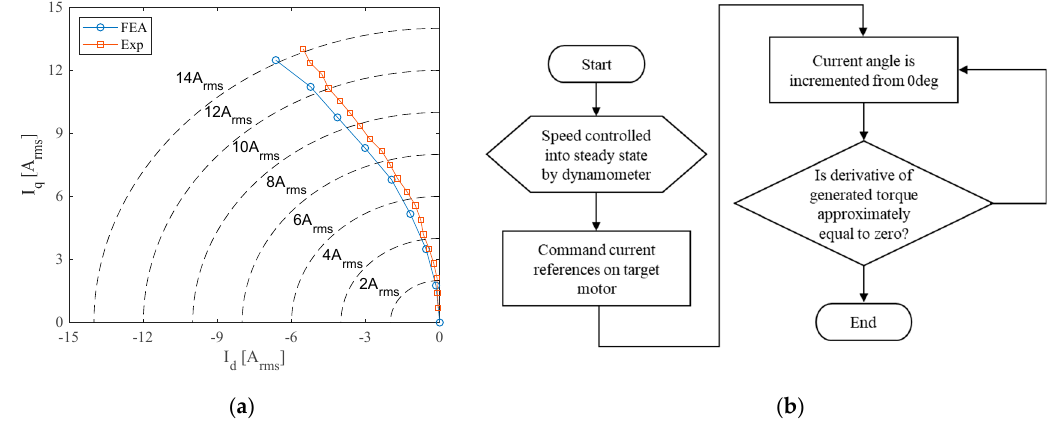
Figure 18. ( a ) MTPA trajectories from FEA and experiments and ( b ) flowchart of under-load test.